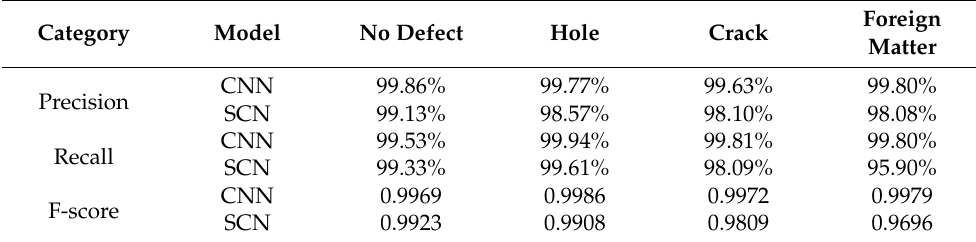
Table 3. Average values of four-classifying model evaluation indices.